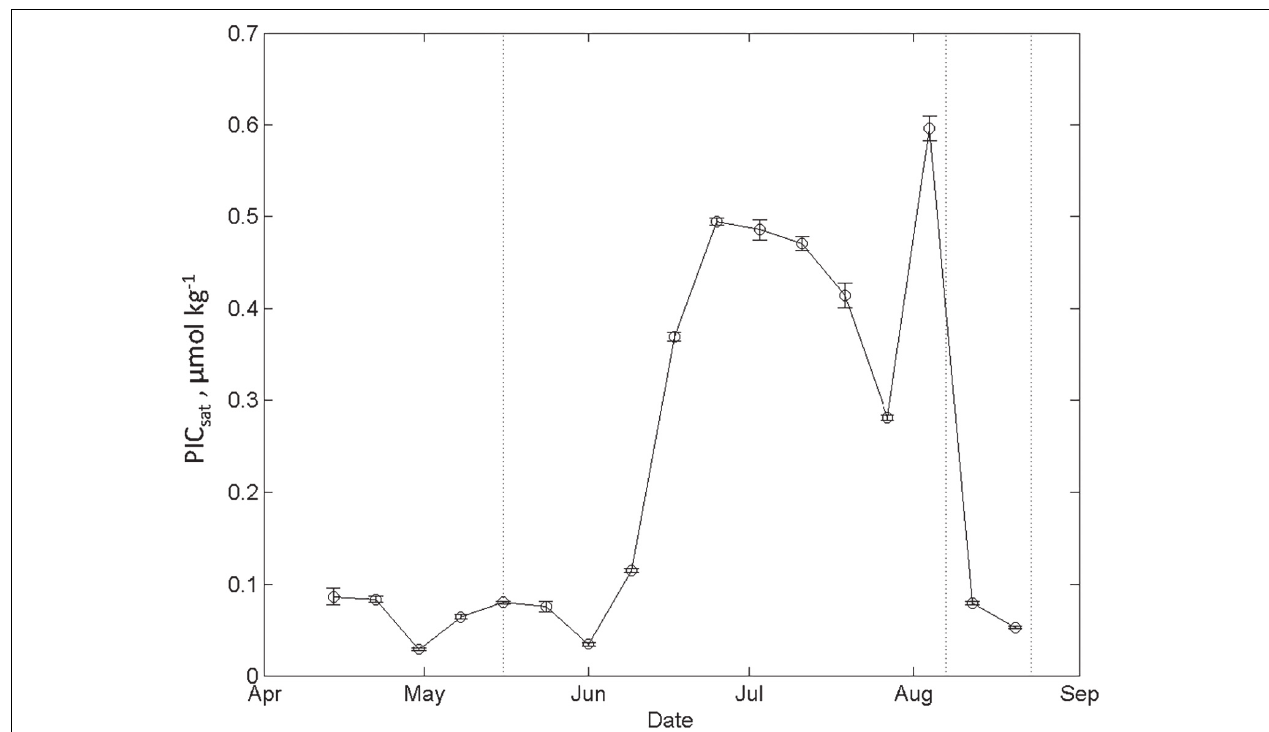
FIGURE 12 | The seasonal evolution of the remotely sensed particulate inorganic carbon (PIC sat , µ mol kg − 1 ) from mid-April to end of August 2014, in the area between longitude 4 and 10 ◦ E, and latitude between 78.5 and 79.5 ◦